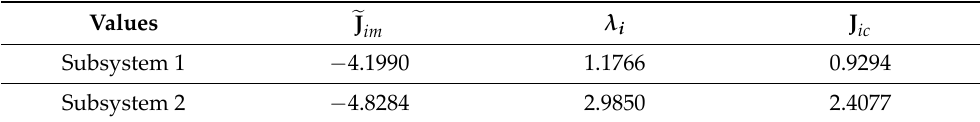
Table 2. Specific values of